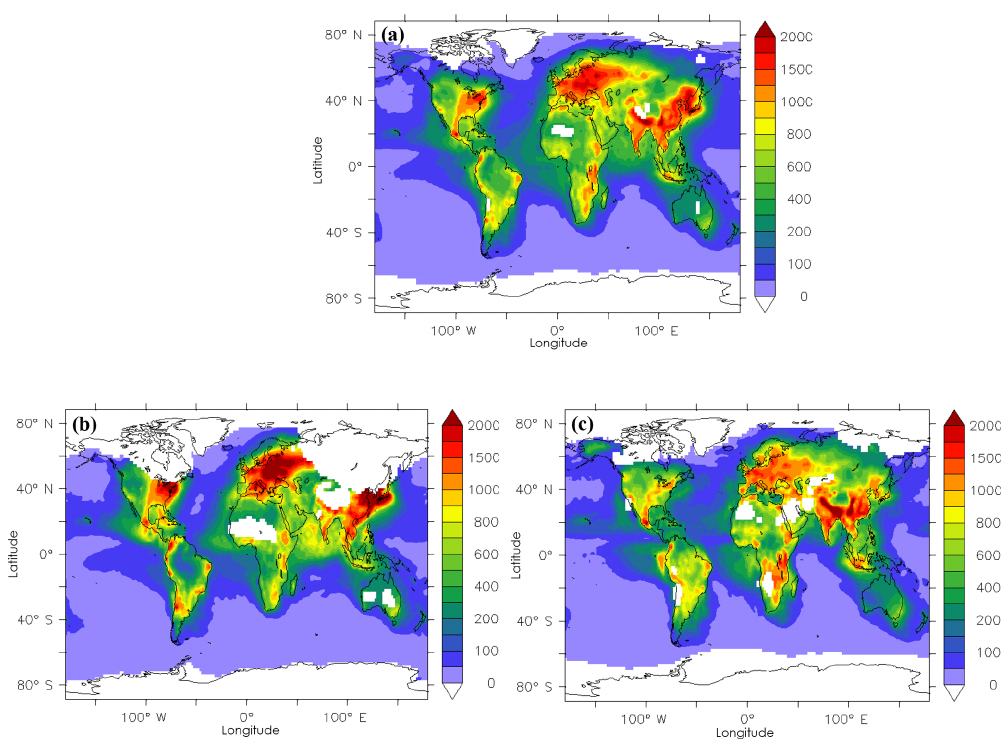
Figure 1. Predicted in-cloud (a) annual, (b) DJF, and (c) JJA mean cloud droplet number concentrations (cm − 3 ) at the lowest cloud-forming level (940hPa). White represents areas that are cloud-free or covered by ice